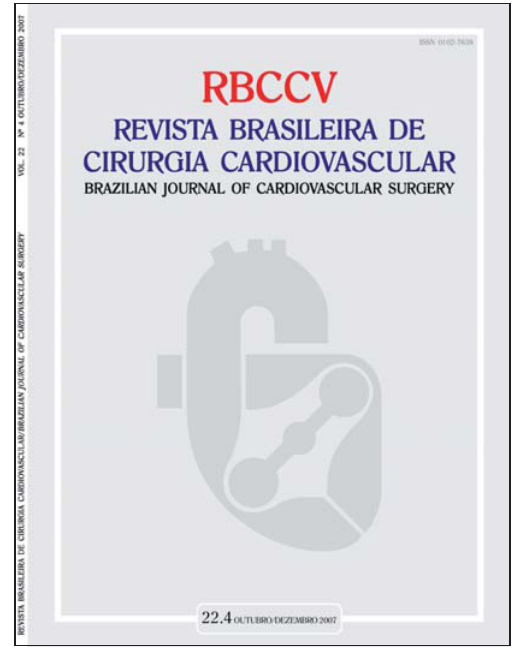
Fig. 2A – Reprodução da capa do volume 17.1, o último produzido antes da atual gestão